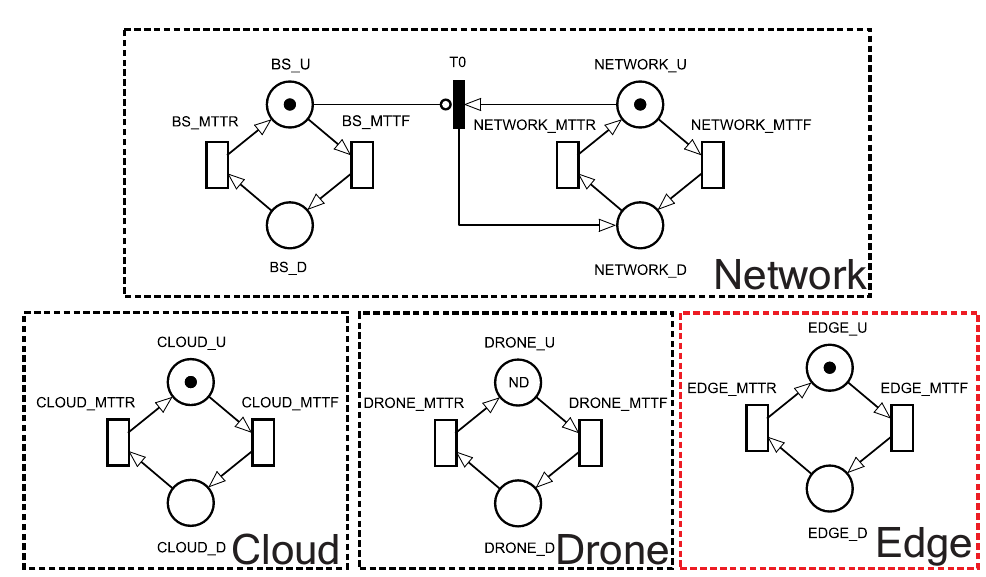
Figure 10. Extended SPN model (when an edge server is added in the system to improve the dependability